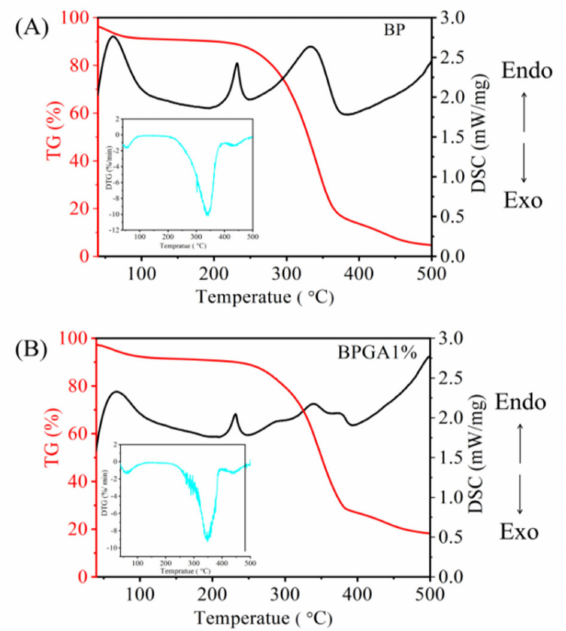
Figure 3. Frames ( A , B ) show the thermal characteristics of the prepared adsorbent materials, BP and BPAG 1%, based on TG-DSC and DTG